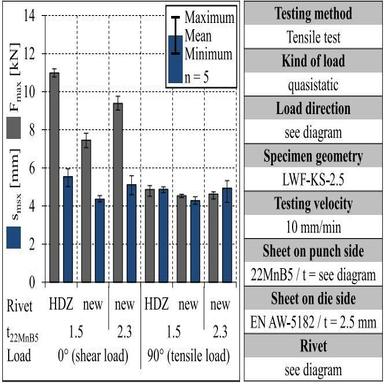
Joint strength with the new rivet and the HDZ rivet for joining 22MnB5 in t = 1.5 mm and t = 2.3 mm.